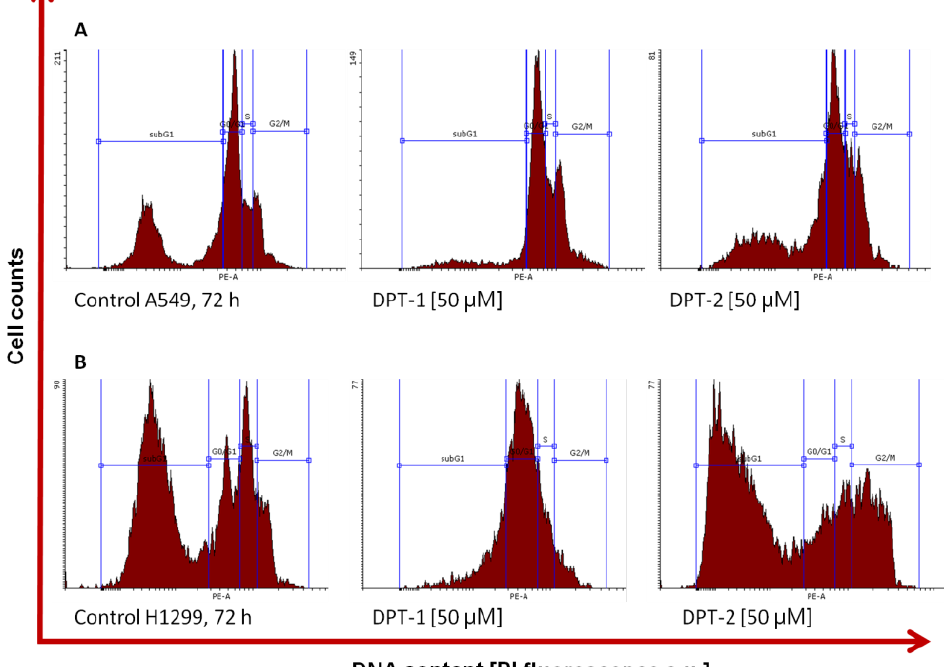
Figure 4. Typical histograms of control and DPT-1 - and DPT-2 -treated A549 ( A ) and H1299 cells ( B ) treated for 72 h at a dose of 50 µM, followed by flow cytometry cell cycle measurements.